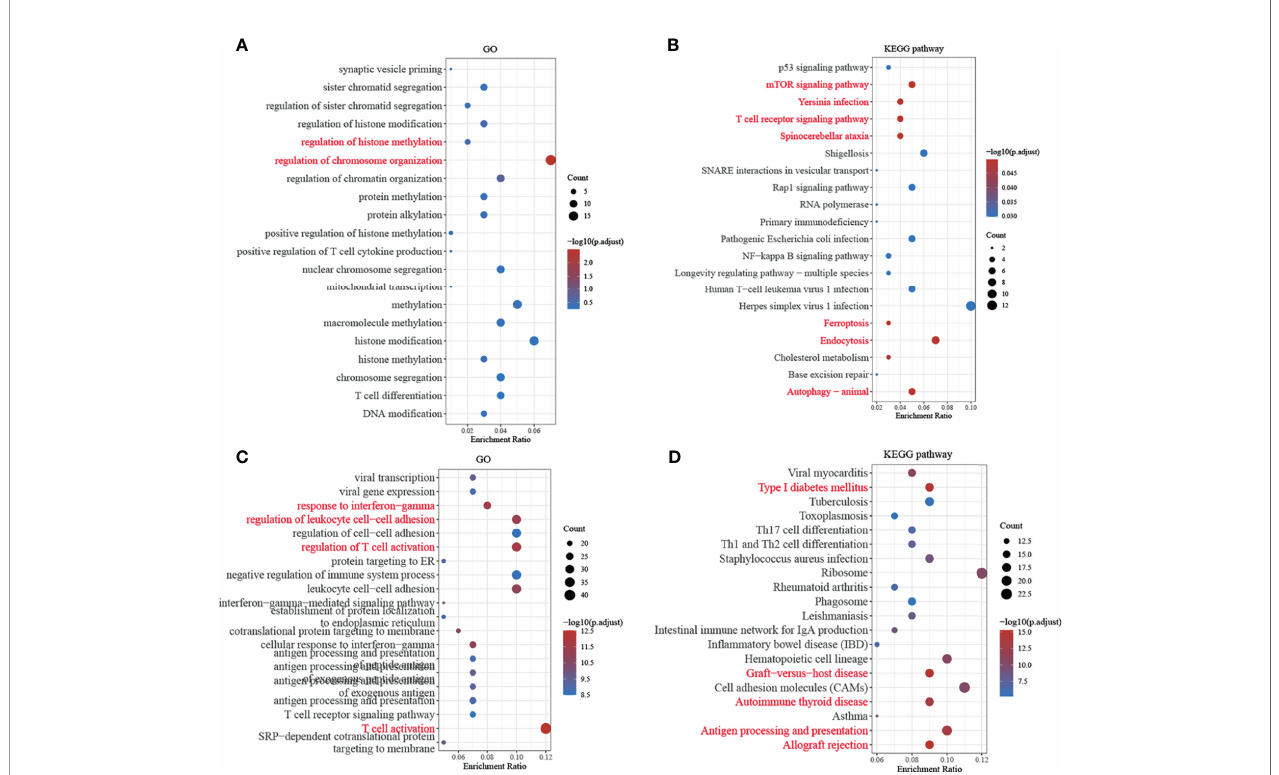
FIGURE 2 | Gene ontology (GO) and Kyoto Encyclopedia of Genes and Genomes (KEGG) analyses of the differentially expressed genes (DEGs). (A, B) Screening of GO terms and KEGG pathway for DEGs from GSE6791. (C, D) Screening of GO terms and KEGG pathway for the differential genes from The Cancer Genome Atlas